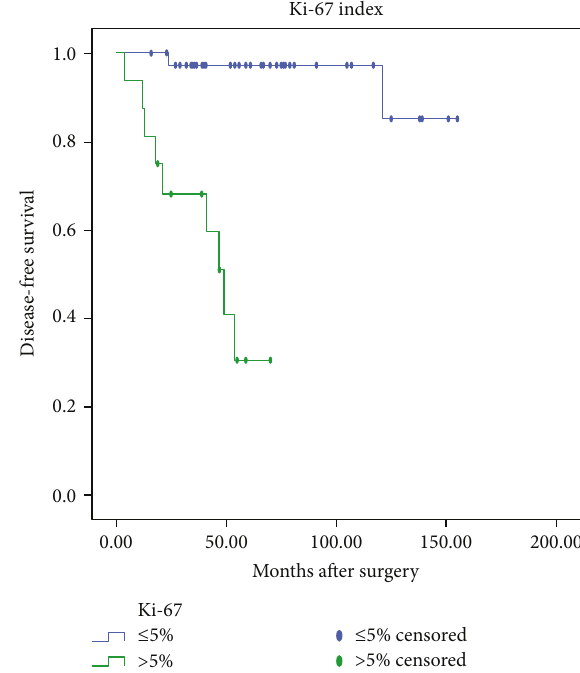
Figure 3: The Kaplan-Meier survival analysis of Ki-67 indicates that index > 5% predicts a poorer prognosis of duodenal stromal tumor.